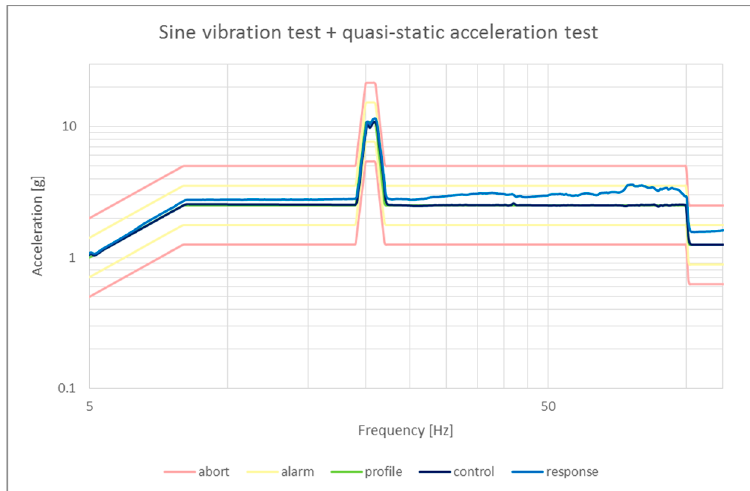
Figure 12. Results of a sine vibration test and QAT.